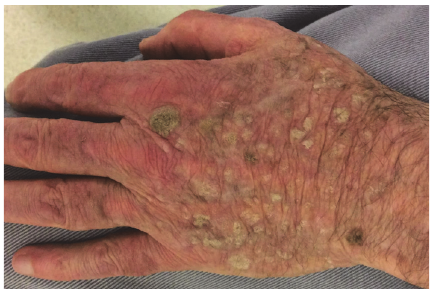
Figure 1: Seborrheic keratoses on the back of the hand.